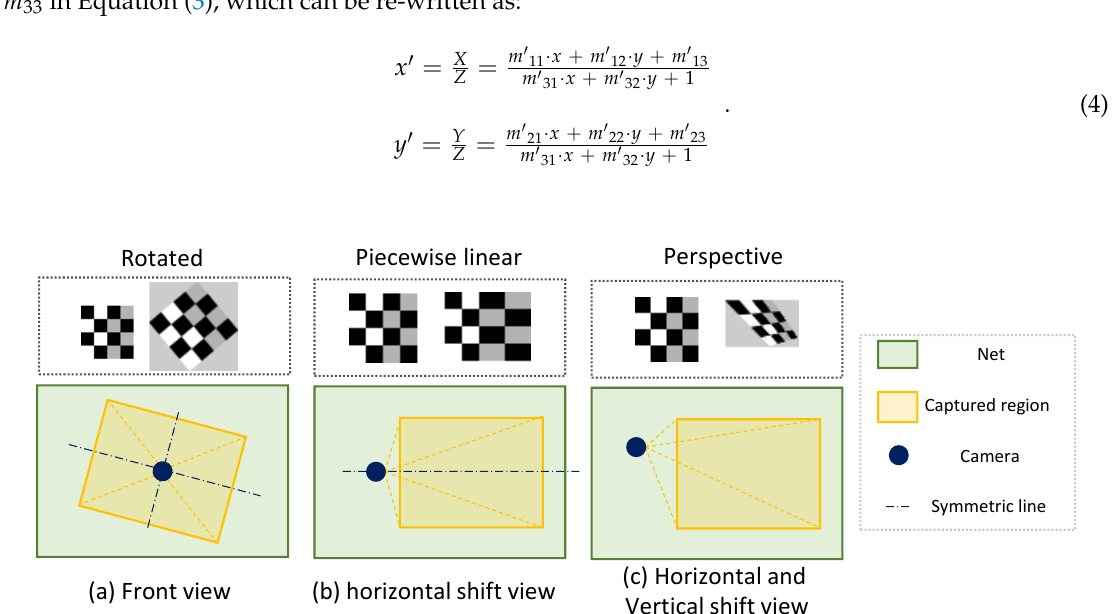
Figure 2. Three common types of distortions in data collection. ( a ) front view; ( b ) horizontal shift view; ( c ) horizontal and vertical shift view.